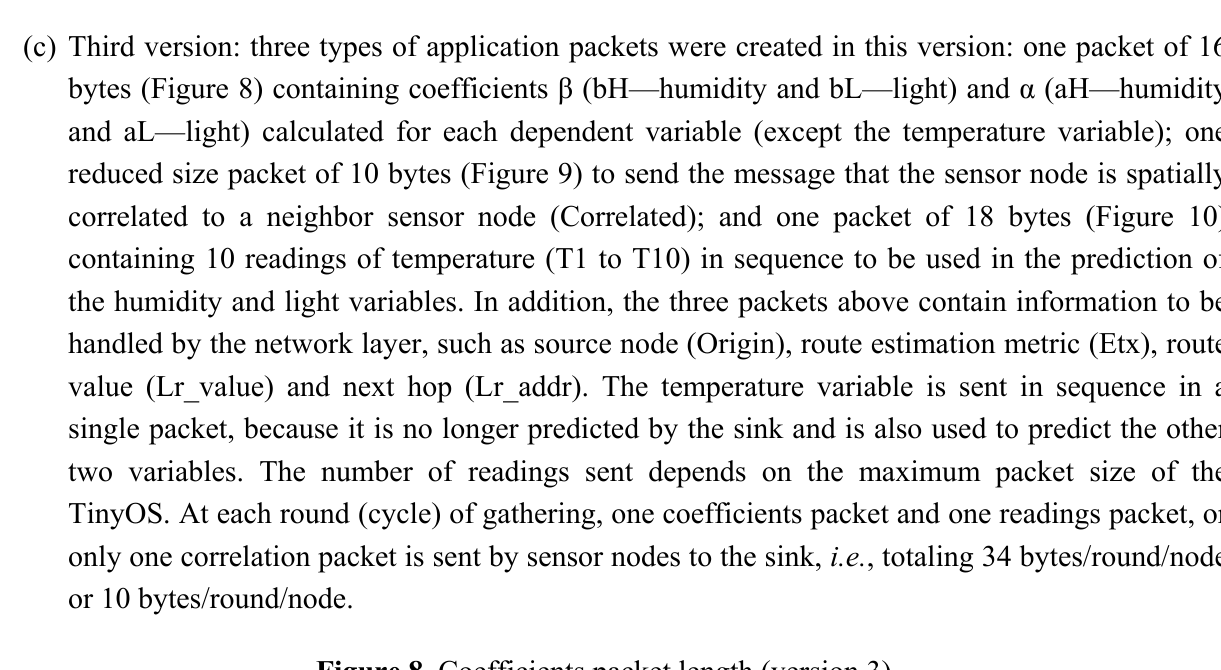
Figure 8. Coefficients packet length (version 3).